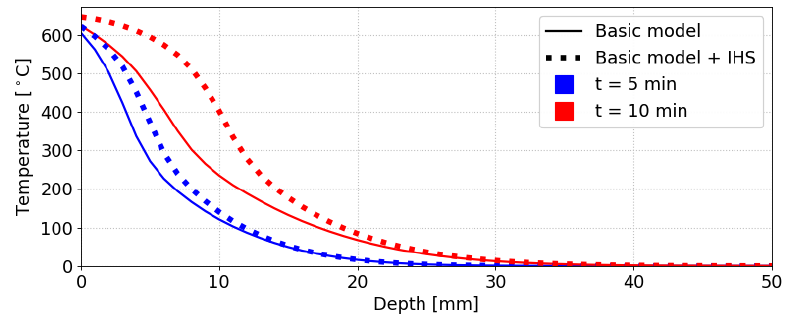
Figure 6. Example of the effect of the internal heat source (IHS). Semi-infinite domain.